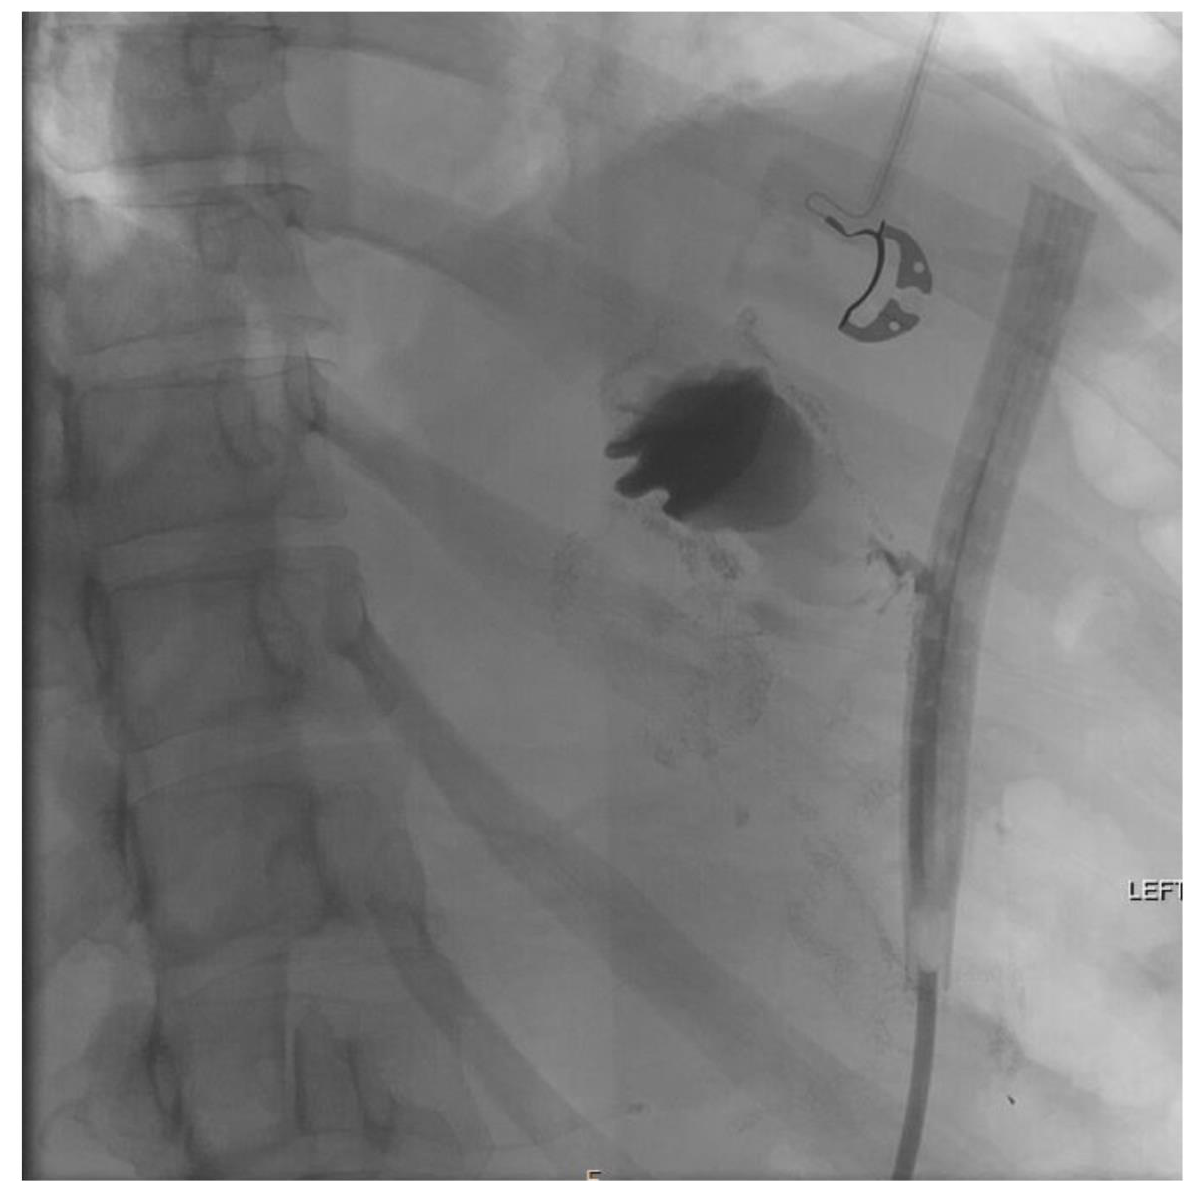
Figure 5. Sinogram showing fistula to orphaned stomach segment.